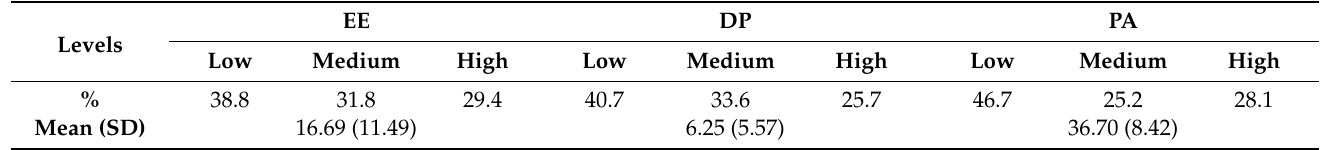
Table 2. Descriptive analysis of the three levels of burnout for each dimension.